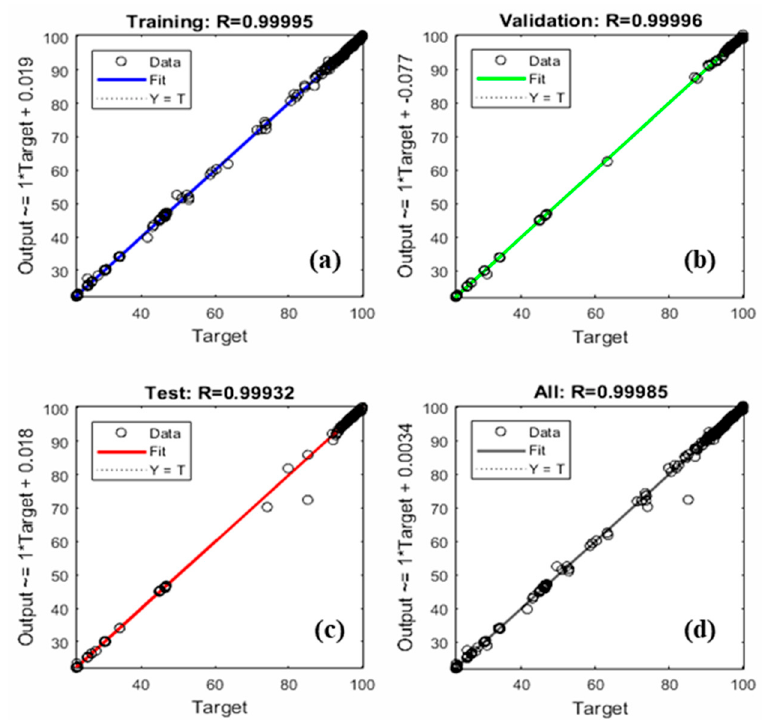
Figure 6. Regression plots of ( a ) training data, ( b ) validation data, ( c ) test data, and ( d ) complete data set of the selected ANN model.